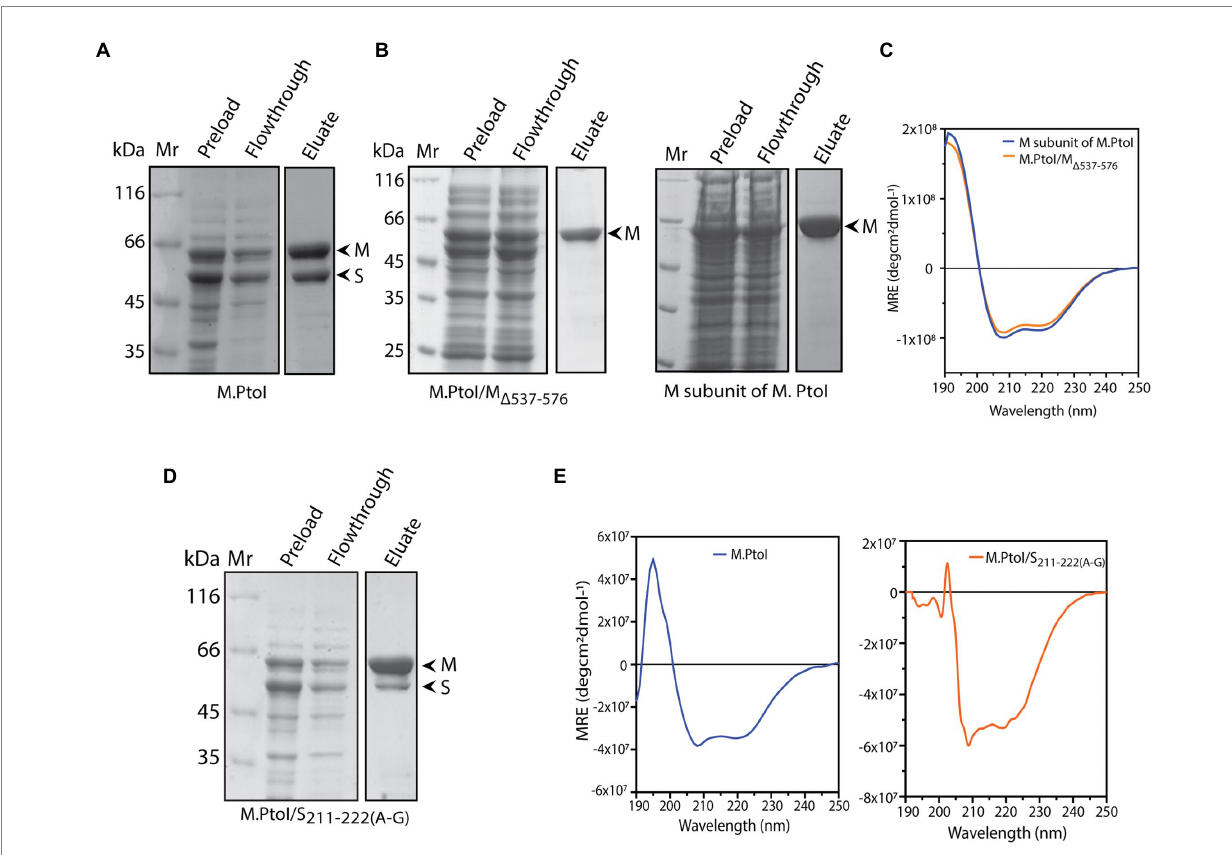
FIGURE 6 (A,B,D) Analysis of purified recombinant M.PtoI proteins. Coomassie-staining of SDS-PAGE. Mr.: molecular weight marker, preload: bacterial whole cell lysates after induction of expression of recombinant proteins, flowthrough: unbound protein fraction after incubation with cobalt affinity beads, eluate: protein fraction after elution with 250 mM imidazole. Arrowheads indicate subunits in eluate fractions. (A) Wild type. Eluate: M and S subunits (molecular weights 63 kDa and 48 kDa respectively). (B) Left panel: M.PtoI/M panel: M subunit of M.PtoI. Eluate: M subunit (molecular weight 63 kDa). (C) CD spectra of M.PtoI M subunit and M.PtoI/M of mean residue ellipticity (MRE). (D) M.PtoI/S 211-222(A-G). Eluate: M and S subunits (molecular weights 63 kDa and 48 kDa respectively). (E) CD spectra of M.PtoI (left panel) and M.PtoI/S 211-222(A-G) (right panel) depicted as a measure of mean residue ellipticity